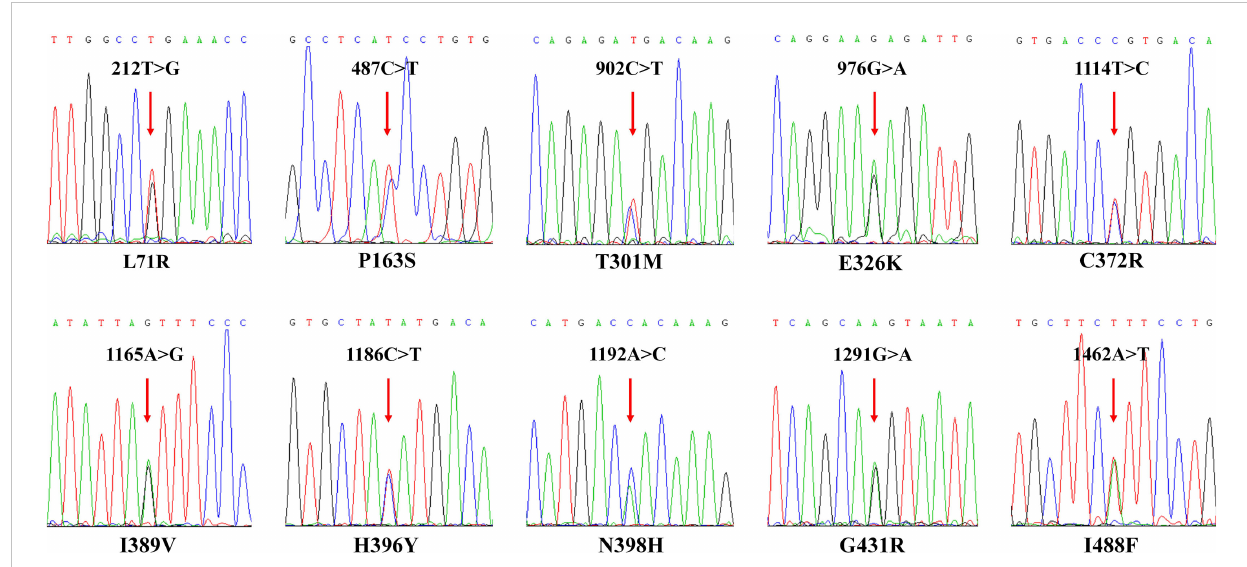
FIGURE 2 Variation veri fi cation of newly detected CYP2C9 variants. Sanger sequencing electropherogram pictures of newly detected CYP2C9 variants. The red arrow indicates that the variation sites detected in carriers and the amino acid substitutions are illustrated at the bottom of captured